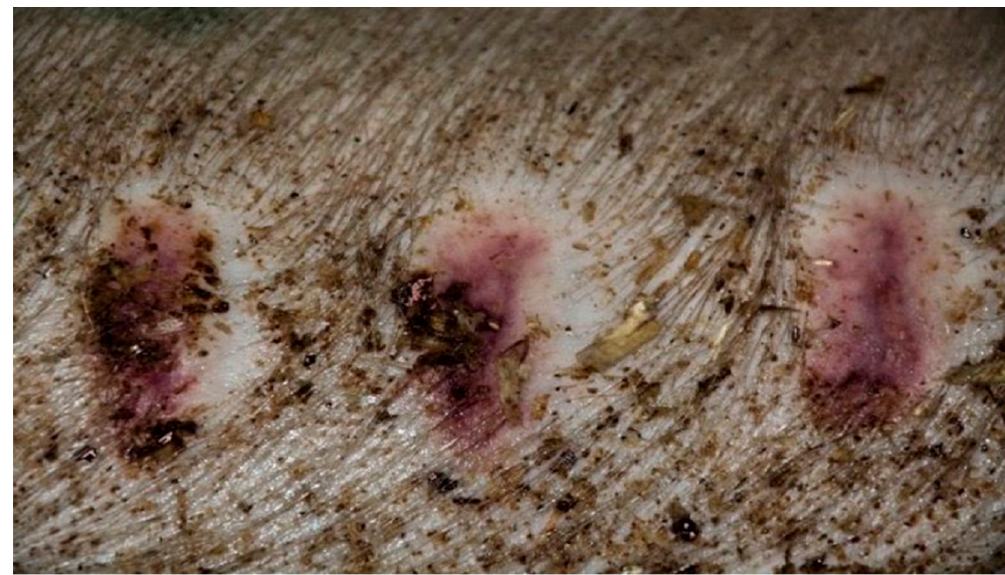
Figure 10. Group D2—burn wound treated with the 1% nanosilver ointment on day 25.